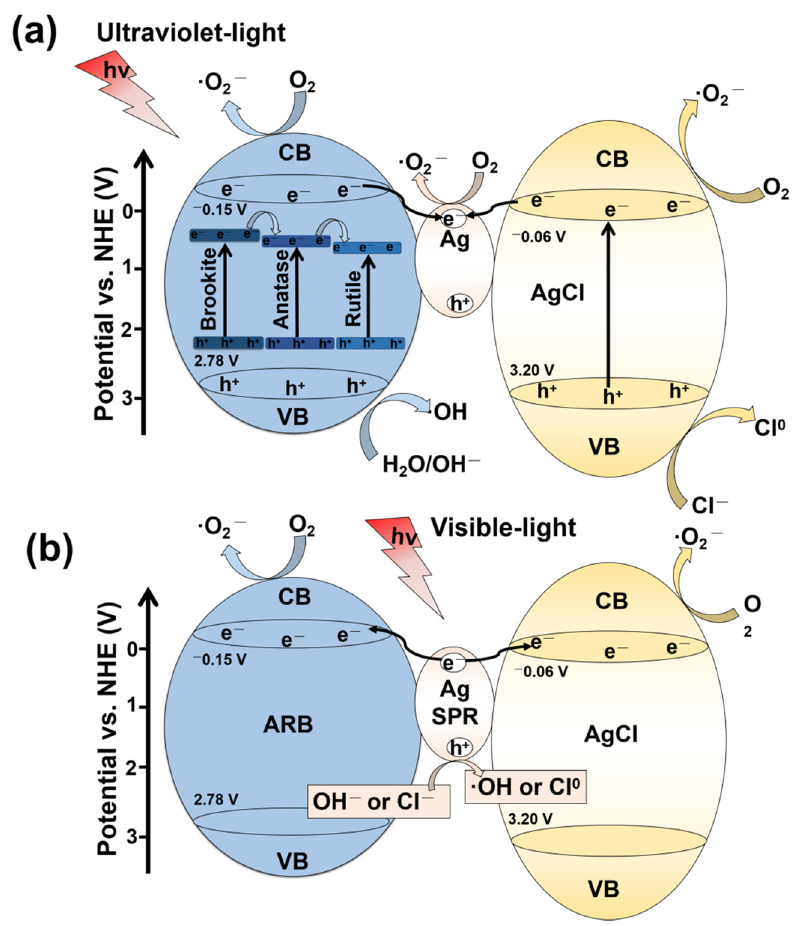
Figure 12: Schematic illustration of the charge separation and transfer in the Ag@AgCl – ARB photocatalysts under ultraviolet light ( a ) and visible light irradiation ( b )